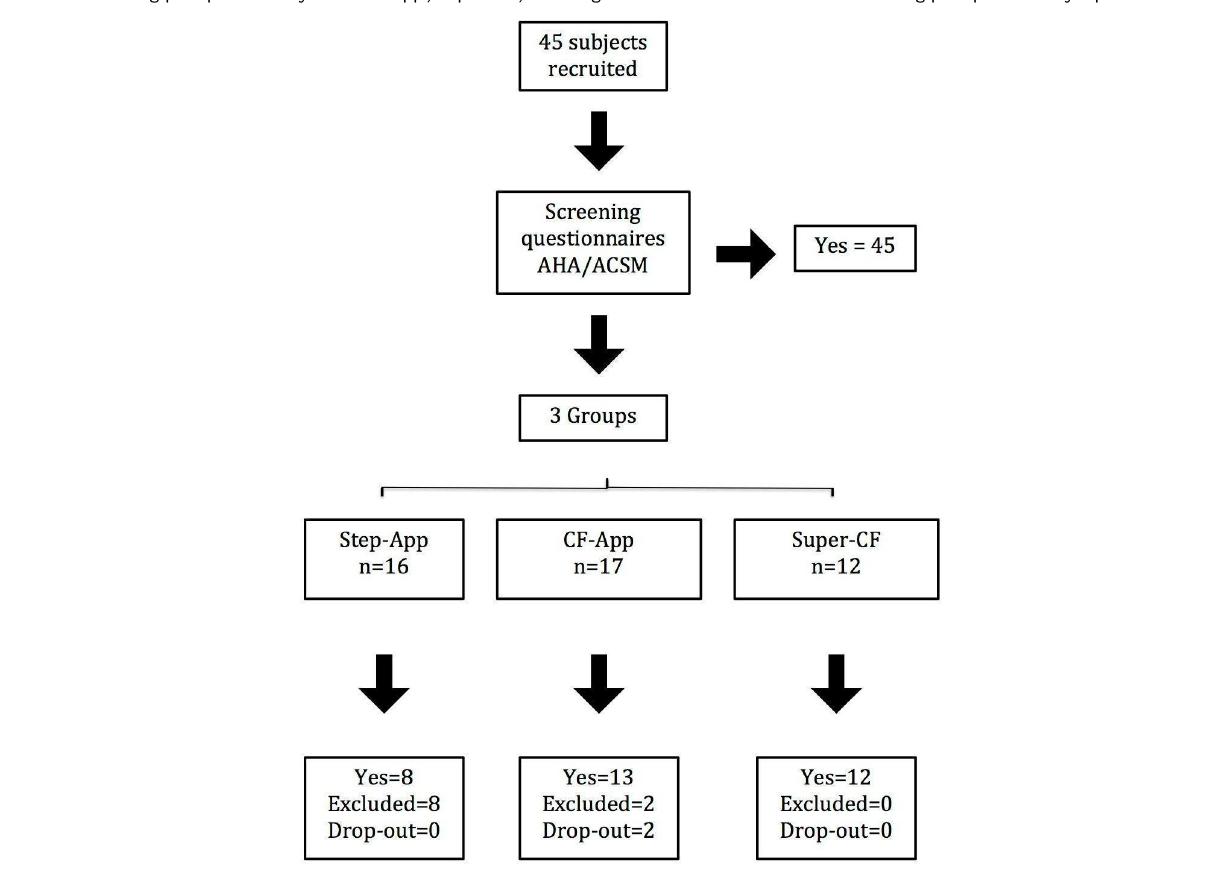
Figure 1. Study enrollment flow-chart. Step-App, 10,000 steps/day training plan provided by a mobile app; CF-App, ACSM